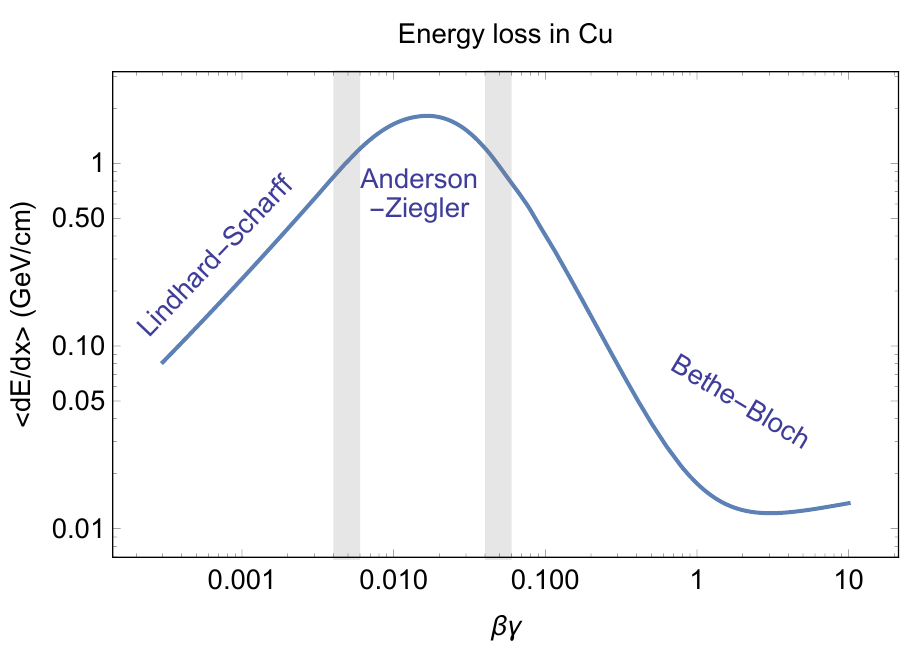
Figure 1 . The average ionization loss of a charged particle moving through solid copper as a p function of (cid:12)(cid:13) = v= 1 (cid:0) v 2 . The Bethe-Bloch and Lindhard-Schar(cid:11) regions are well predicted by theory [41]. The Anderson-Ziegler region is an interpolation from data, and the gray bands denote the interface between these